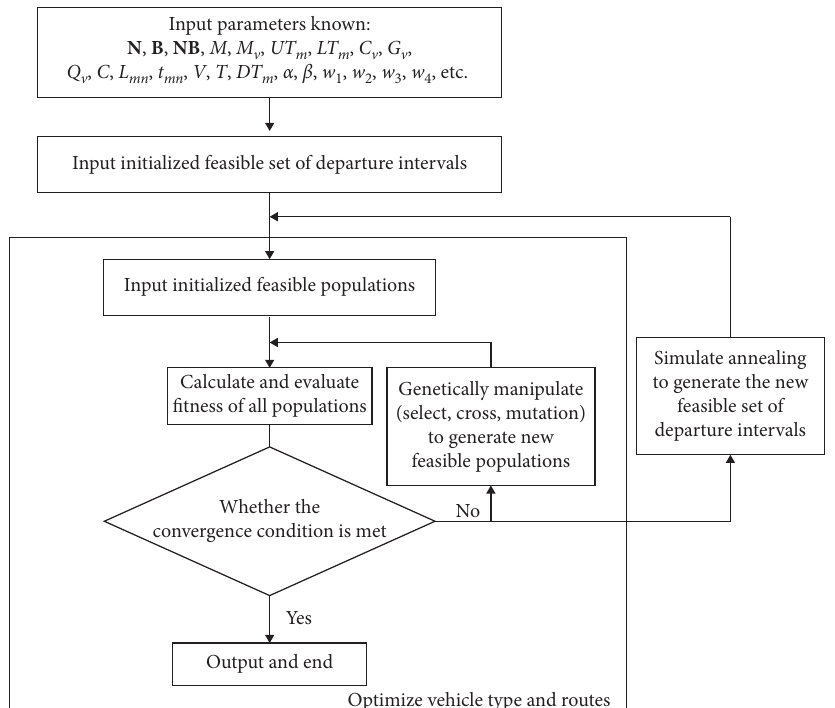
Figure 4: Flow chart of the hybrid of